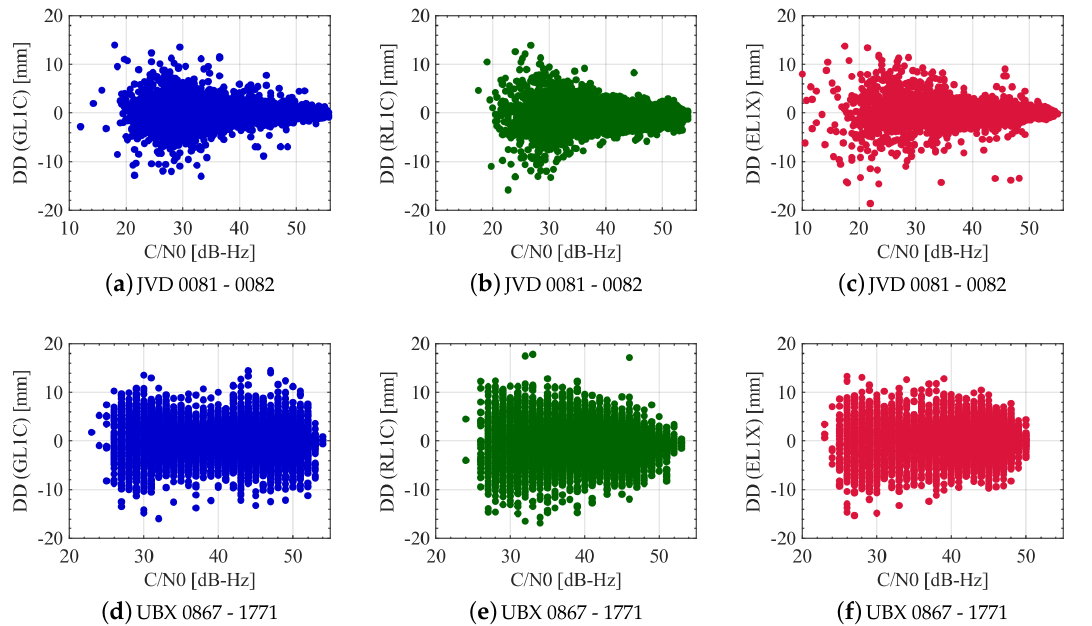
Figure 11. DDs of L1 carrier phase observations from all satellites for different receiver combinations with respect to the C/N 0 values of the non-reference satellites. GPS, GLONASS and Galileo noise levels are shown in blue, green and red colours,